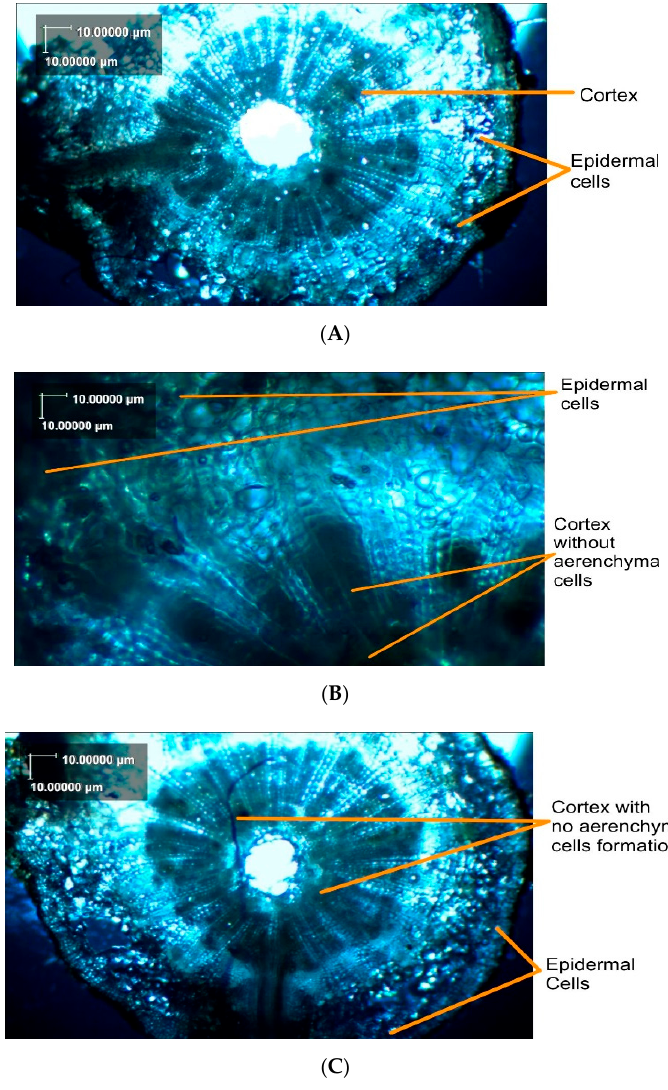
Figure 2. Root sections of okra plants grown from different concentrations of NaN 3 -treated seeds show no aerenchyma cells formed under non-waterlogging conditions. ( A ) 0% NaN 3 , ( B ) 0.02% NaN 3 , ( C ) 0.05% NaN 3 .